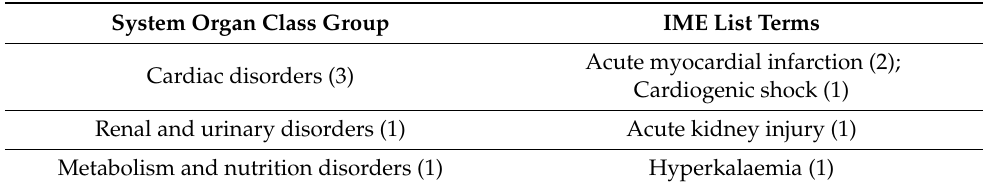
Table 8. Relationship between the Adverse Drug Reactions of the notifications that progressed to death with the terms belonging to the Import Medical Event (IME)